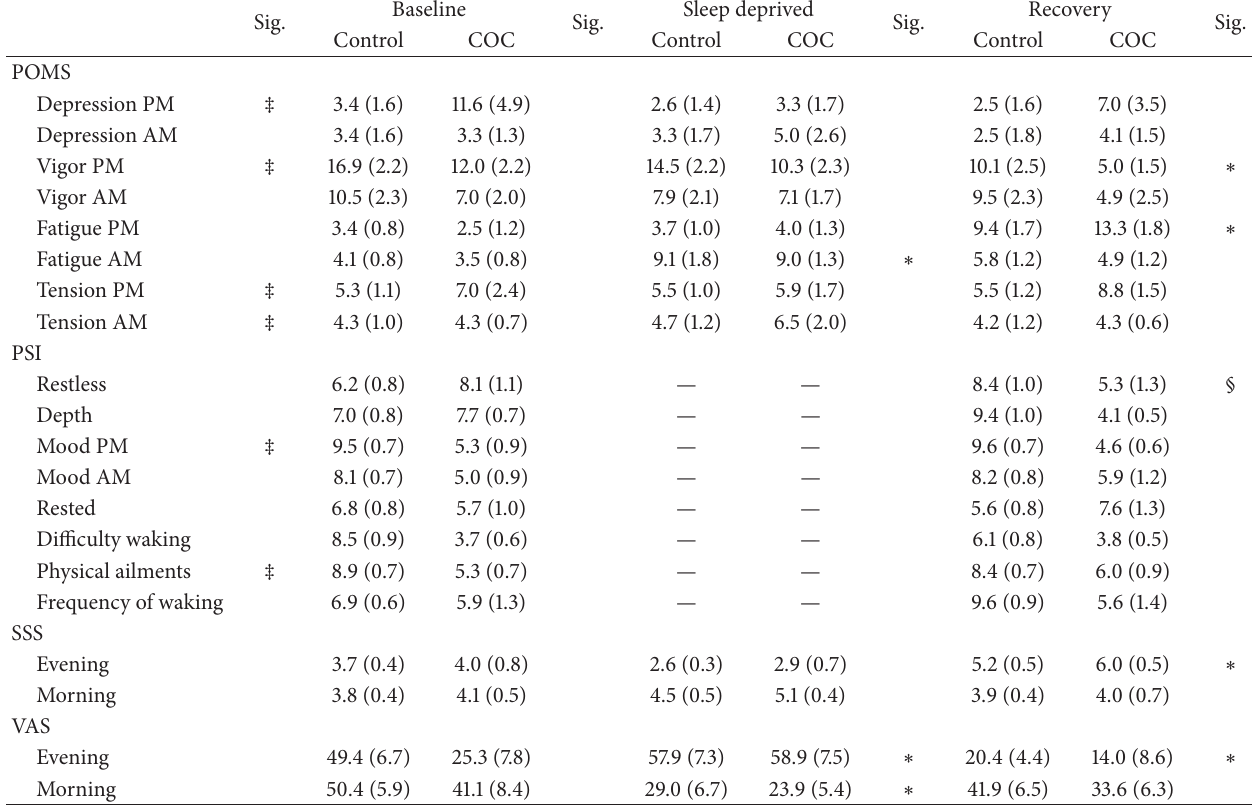
Table 3: Profile of Mood States (POMS), Post-Sleep Inventory (PSI), Stanford Sleepiness Scale (SSS), and Visual Analog Scale (VAS) assessments of sleepiness and mood in control (control) versus cocaine-dependent (COC) participants data are displayed as mean (Standard